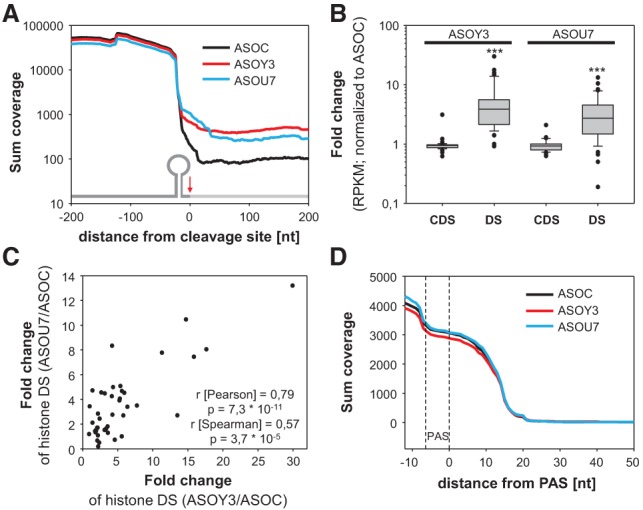
The depletion of the Y3 ncRNA impairs the 3′ end processing of replication-dependent histone pre-mRNAs. (A) Total RNA isolated from HEK293 cells transfected (48 h) with control (black), Y3-directed (red), or U7-directed (blue) ASOs was analyzed by RNA sequencing. The sum coverage of 46 histone transcripts observed in three independent analyses was determined 200 nucleotides upstream of and downstream from the cleavage sites. The inserted schematic indicates (5′ to 3′) (1) the SL, including the region 5′ of the cleavage site (dark gray); (2) the cleavage site (red arrow); and (3) the region 3′ of the cleavage site (light gray). (B) The fold change (to controls [ASOC]) of RPKM observed upon the depletion of Y3 or U7 in the CDS or 3′ of the cleavage site (DS) for each of the 46 histone transcripts is depicted in box plots. Statistical significance was determined by Student's t-test, (***) P < 0.001. (C) The fold change in DS abundance of U7-depleted samples was plotted over the respective change determined in Y3-depleted samples for each histone mRNA analyzed in B. Pearson and Spearman correlation parameters are indicated in the graph. (D) The sum coverage for 3′ ends of eight nonhistone mRNAs (ACTB, ACTG1, EEF2, GAPDH, RPL8, RPL29, RPS2, and PPIB) was analyzed as in A. The position of the PAS serving as the anchor is indicated by dashed lines.